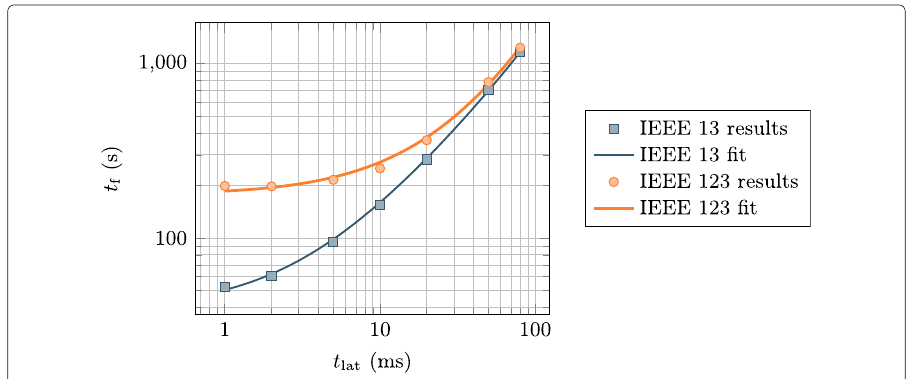
Fig. 9 The plot shows the time t f needed for convergence with respect to the different communication latencies t lat . Results for the IEEE 13 and IEEE 123 node test feeders are shown